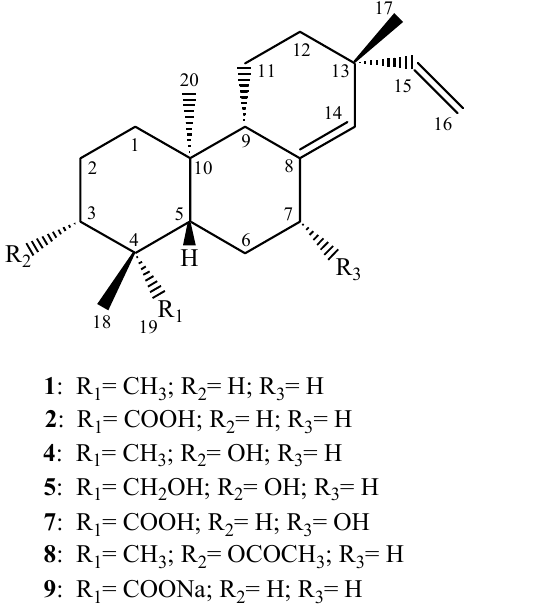
Figure 1 . Chemical structures of the pimarane diterpenes from Viguiera arenaria